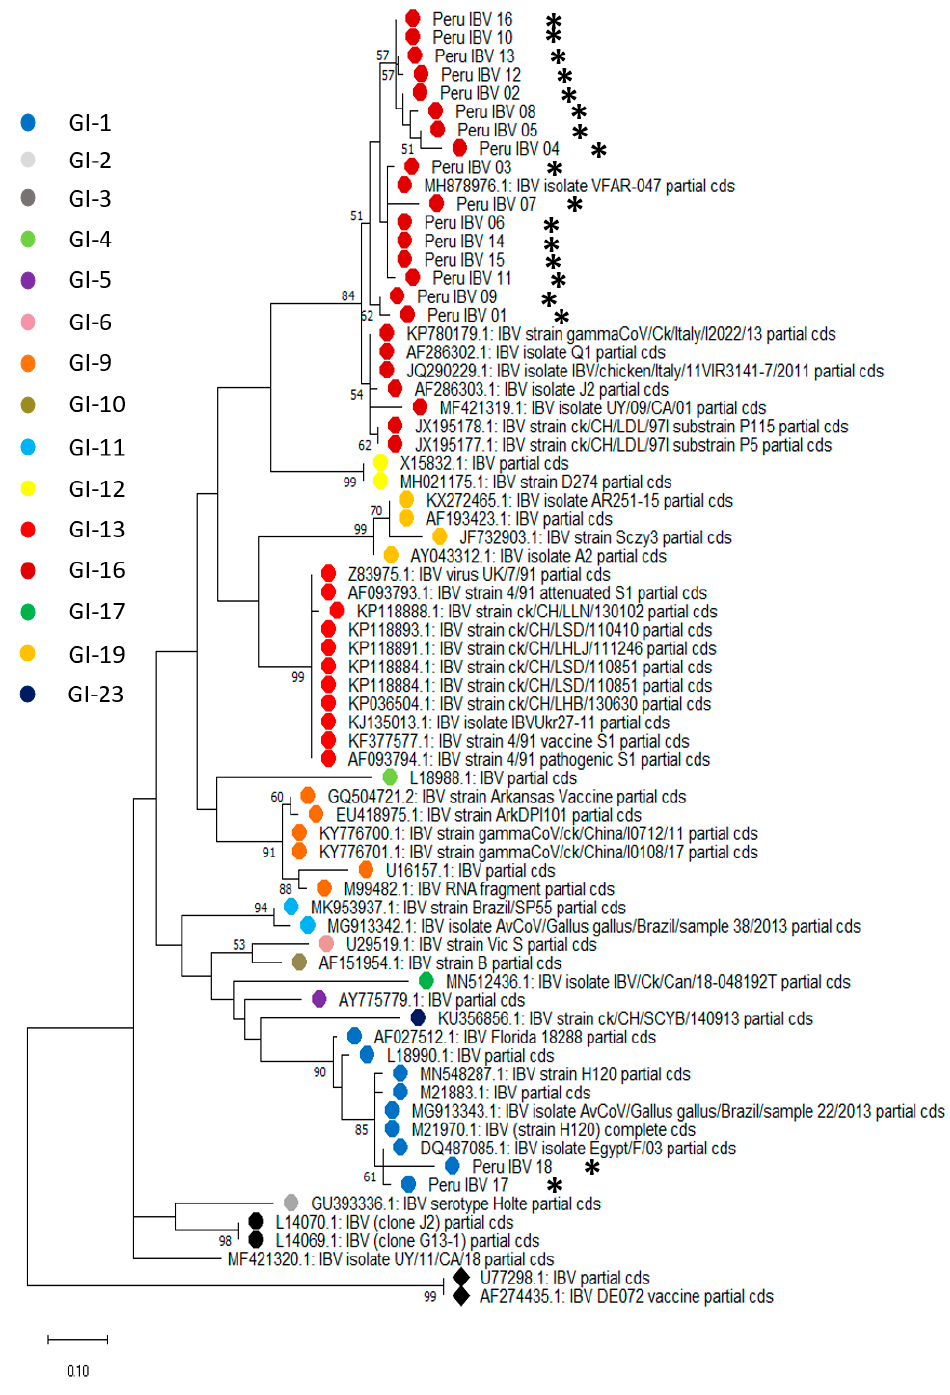
Figure 3. Phylogenetic analysis reveals GI-16 and GI-1 circulation in poultry farms in Peru. Isolated samples were processed for RNA extraction and a PCR that targeted the hypervariable region III (HVR-III) allowed the identification of GI-16 and GI-1 lineages in Peru. The evolutionary history was inferred by using the maximum likelihood method and a poison model. The percentage of trees in which the associated taxa clustered together is shown next to the branches. A discrete gamma distribution was used to model evolutionary rate differences among sites. The tree is drawn to scale, with branch lengths measured in the number of substitutions per site. This analysis involved 70 amino acid sequences. Asterisks represent the sequences obtained in the current study.